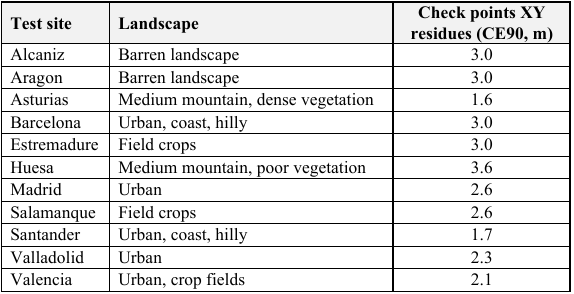
Table 3. Accuracy assessment on Spain test sites